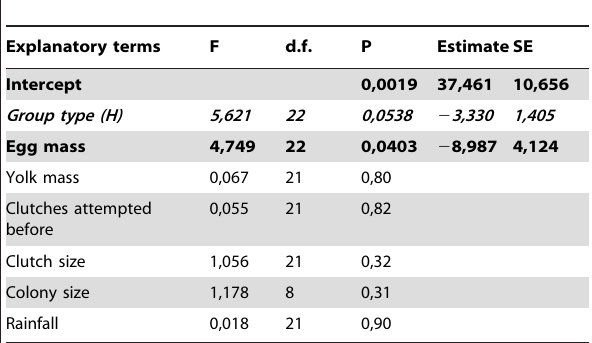
Table 5. Factors affecting yolk androstenedione concentrations. Table 6. Factors affecting yolk corticosterone